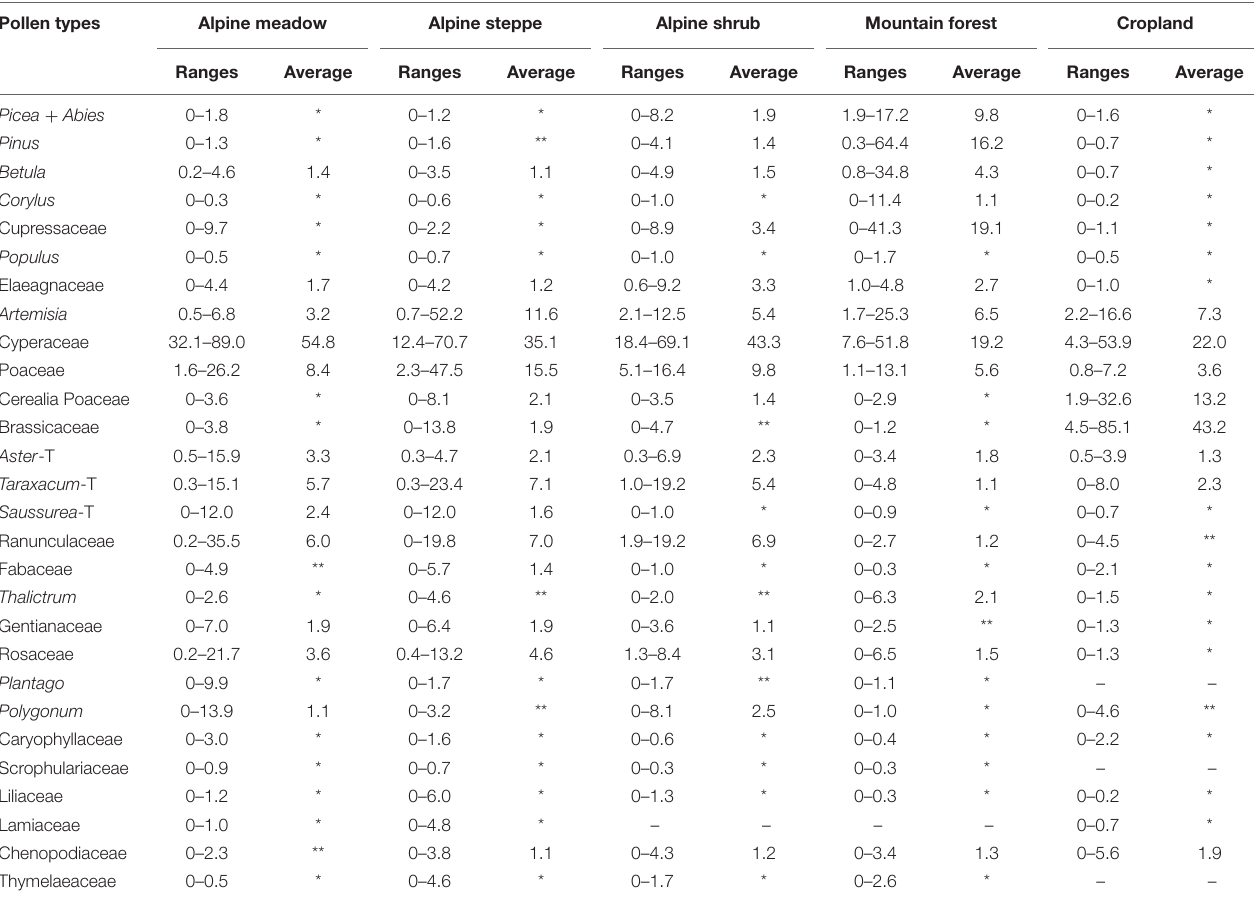
TABLE 2 | Ranges and average percentages (%) of the main pollen types on different vegetational communities in typical agro-pastoral ecotone in the eastern Tibetan